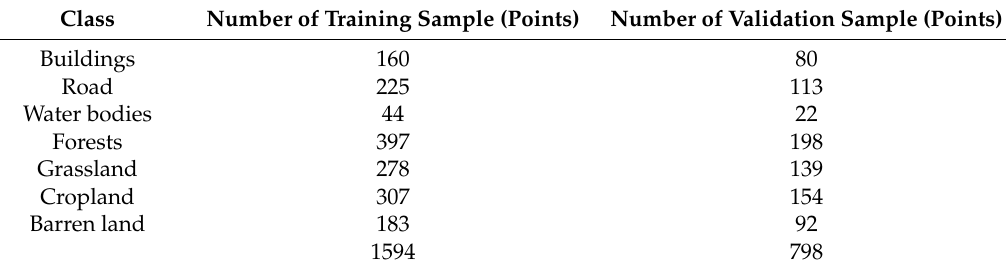
Table 2. The number of classification training and validation data per